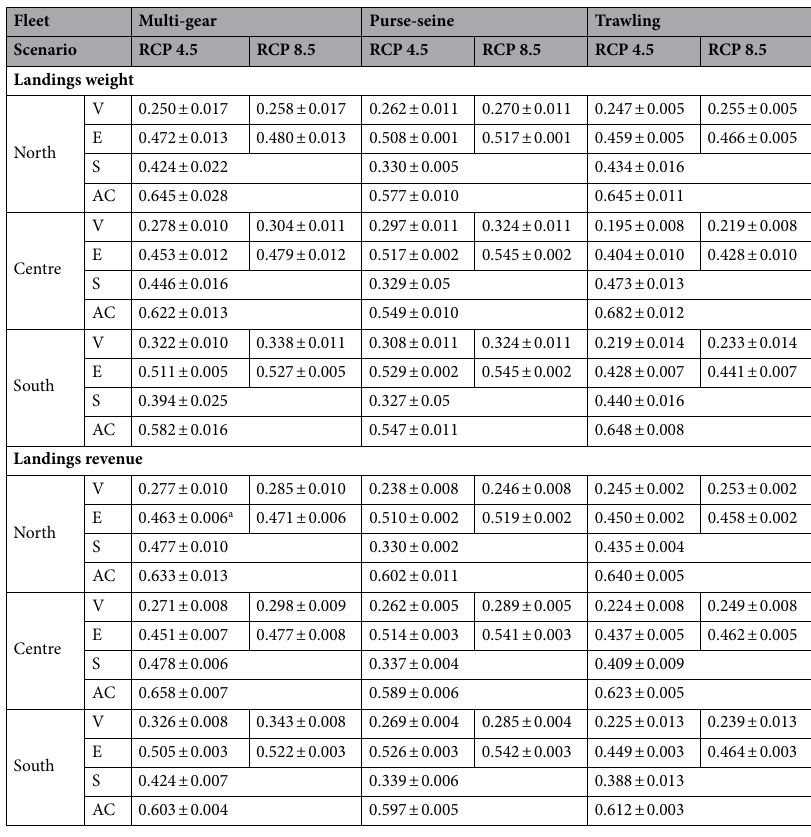
Table 1. Mean and standard deviation values of ecological vulnerability (V), exposure (E), sensitivity (S) and adaptive capacity (AC) of the landings weight and landings revenues for each area (North, Centre and South), fleet (multi-gear, purse-seine and trawling) and climate change scenario (RCP 4.5 and RCP